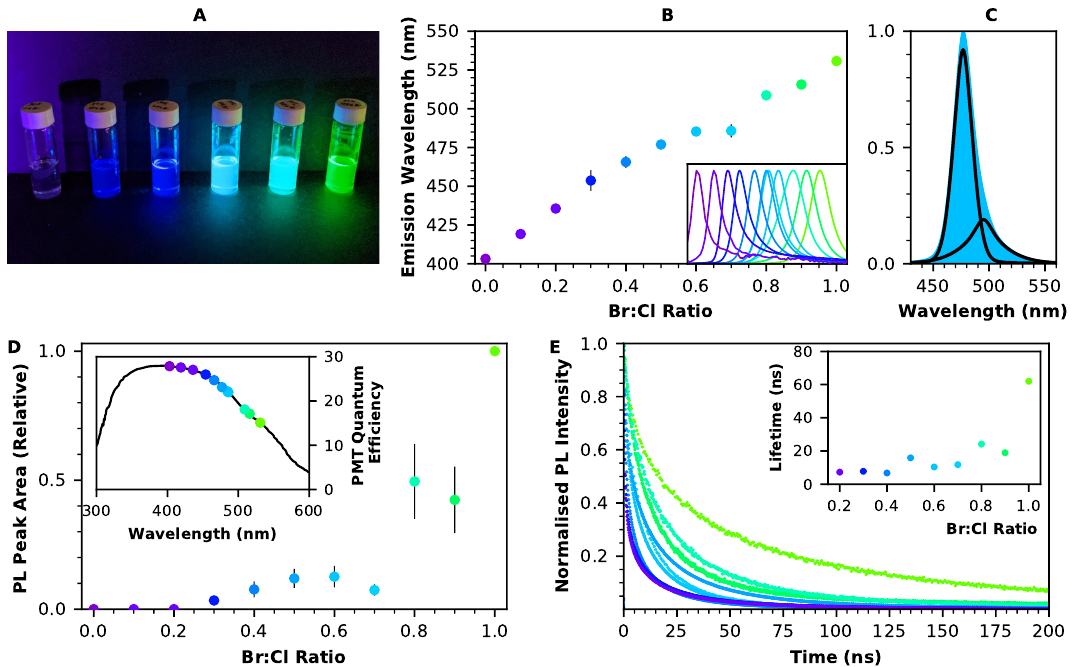
Figure 1. Optical characterisation for FAPbBr 3 x Cl 3 ( 1 − x ) nanocrystals. ( A ) Photograph of dispersed FAPbBr 3 x Cl 3 ( 1 − x ) nanocrystals under UV light; from left to right: x = 0, 0.2, 0.4, 0.6, 0.8, 1 ( B ) The peak emission wavelength of FAPbBr 3 x Cl 3 ( 1 − x ) nanocrystals is dependent on the halide content of the nanocrystals. Inset shows the normalised photoluminescence spectrum for each sample. ( C ) Photoluminescence peaks from FAPbBr 3 x Cl 3 ( 1 − x ) nanocrystals can be fitted with two components. Fitting is shown here for FAPbBr 1.5 Cl 1.5 . ( D ) The area under the photoluminescence peaks of the mixed-halide nanocrystals is strongly influenced by the halide content, with more bromine giving a brighter nanocrystal. Inset shows the quantum efficiency of ET Enterprises 9256B PMT, marked with the wavelength of each perovskite nanocrystal dispersion. ( E ) Photoluminescence decay spectra for mixed-halide perovskite nanocrystals in PMMA. Inset shows the average lifetime for each sample, as obtained from a two-exponential